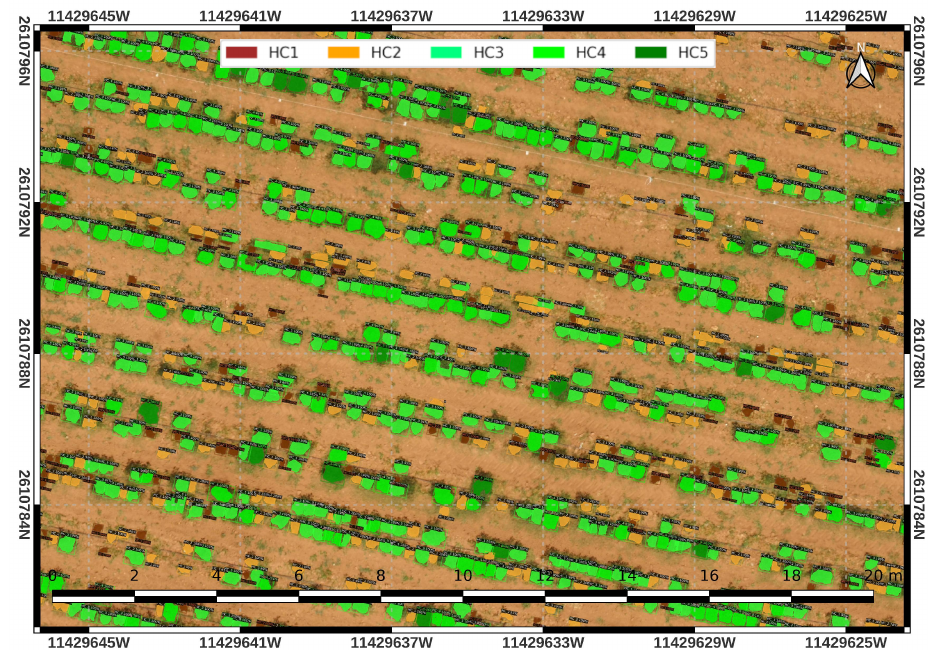
Figure 12. Instance detections and segmentation at orthomosaic level area.